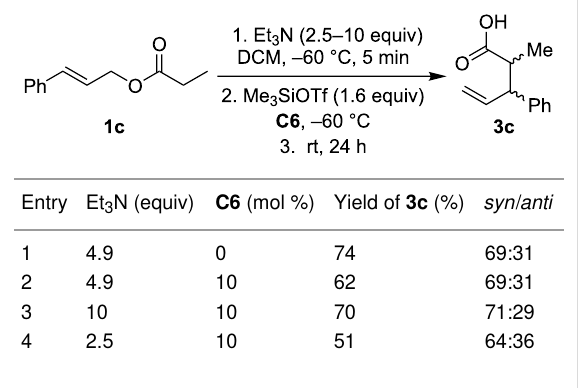
Table 4: Effect of the amount of base on the Ireland–Claisen rear- rangement of 1c in the presence of C6